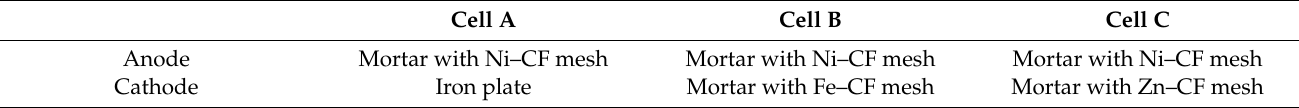
Table 11. Cell arrangement of metal-coating